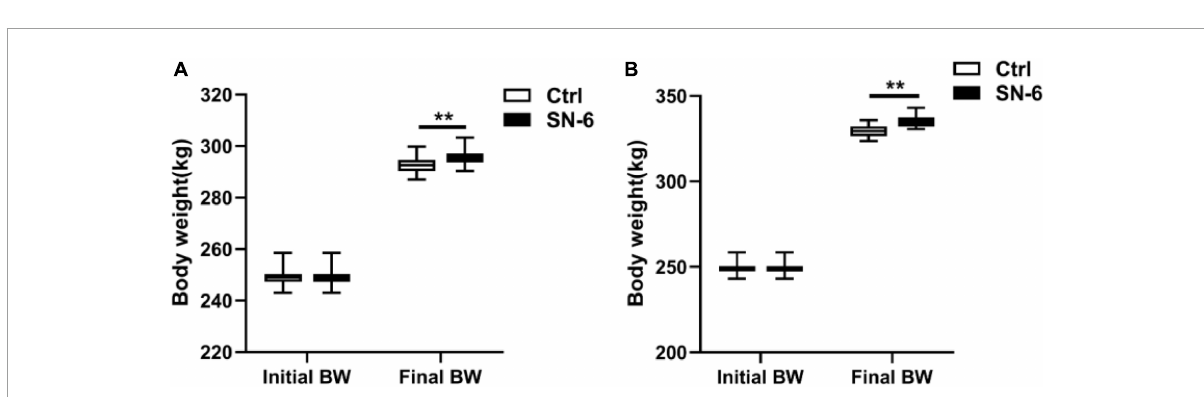
FIGURE3 Body weight of Simmental in the control and SN-6 treated groups. (A) Feeding for 33 days. (B) Feeding for 61 days. The values are presented as the mean ± SD ( n = 33). ** p < 0.01 as statistically